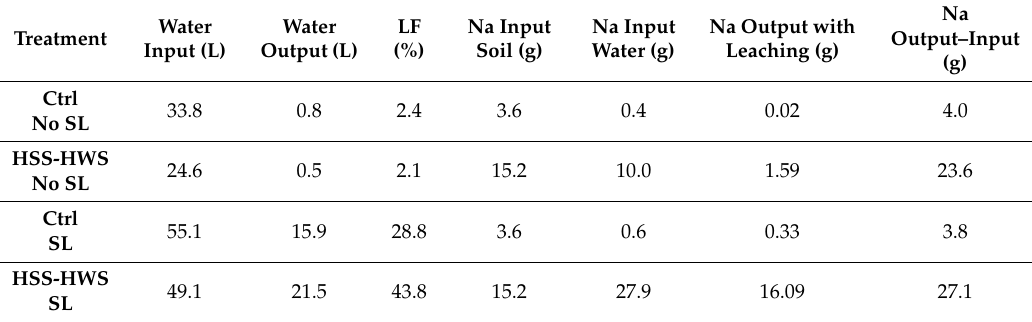
Table 2. Total amount of water and Na supplied to the